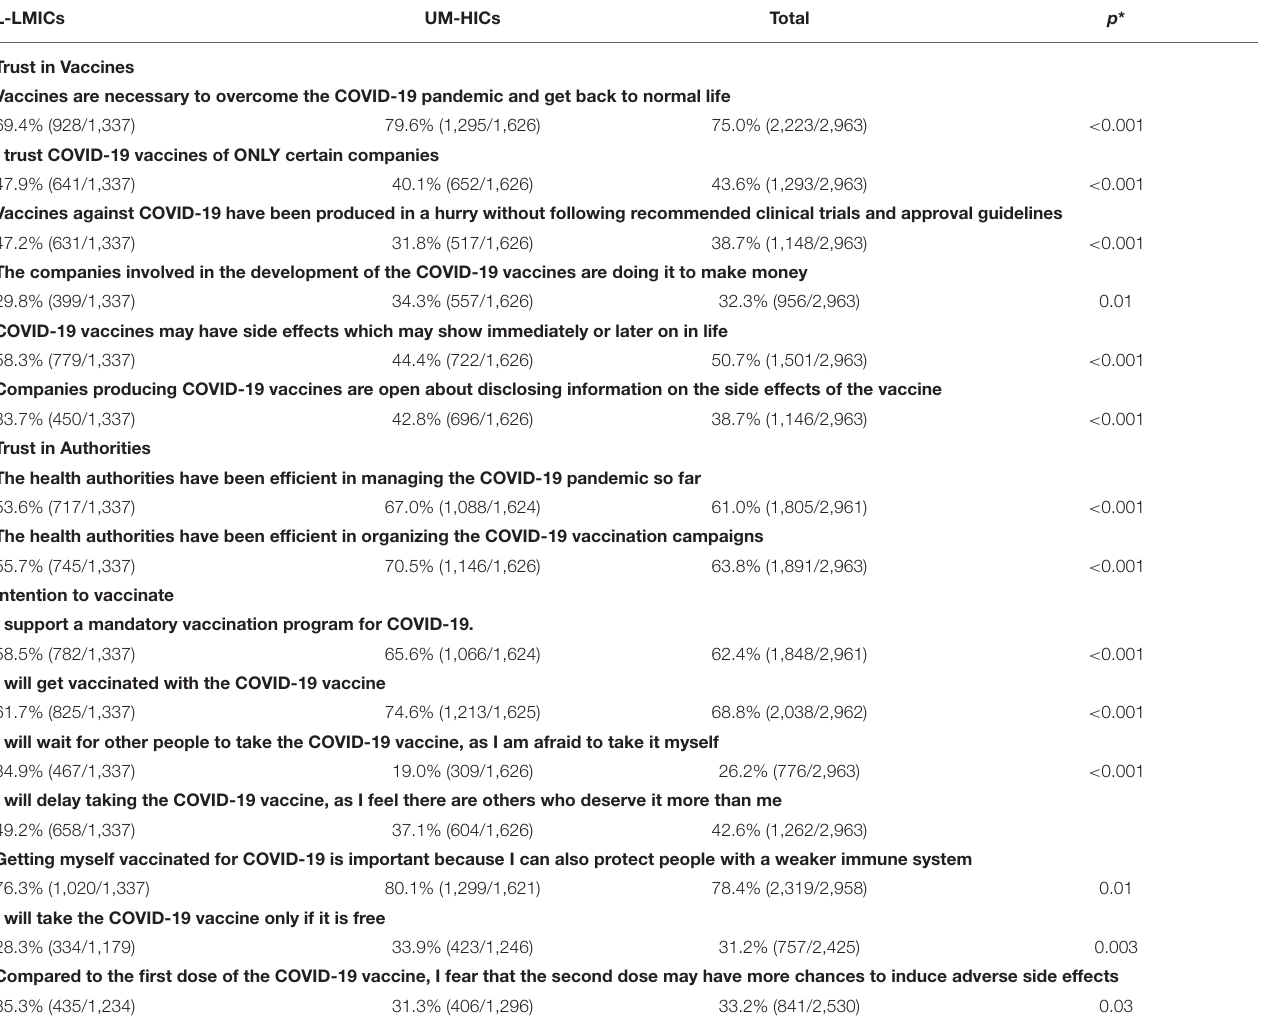
TABLE 3 | Comparison of responses to different survey questions between L-LMICs and UM-HICs– Data are presented as % ( n ). L-LMICs UM-HICs Total p * Trust in